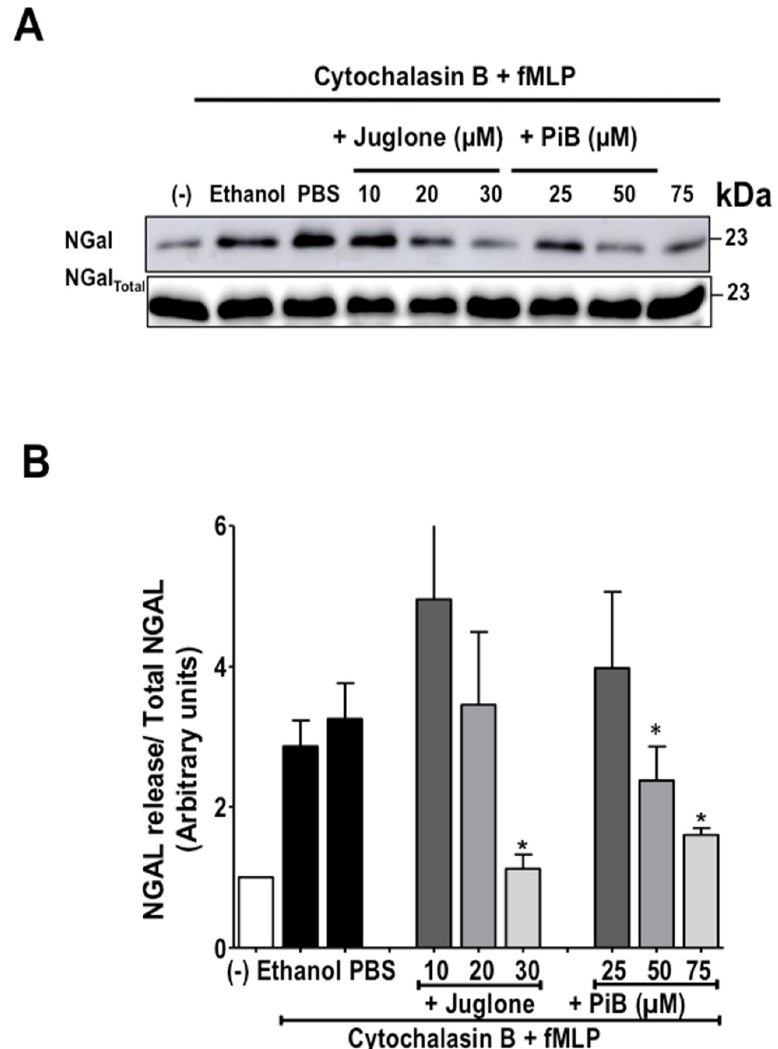
Figure 5. Effect of juglone and PiB on NGal release by human neutrophils. ( A ) Cells were pretreated or not with increasing concentration of Juglone dissolved in ethanol (0, 10, 20, 30 μ M) and PiB (0, 25, 50, 75 μ M), then with cytochalasin B (5 μ g/mL) before stimulation with fMLP (10 − 6 M). Control cells were treated with ethanol (0.001% or PBS) then with Cytochalasin B (5 μ g/mL) and stimulated by fMLP in the same conditions. After centrifugation, equal amounts of supernatant samples and neutrophils lysates were subjected to SDS-PAGE followed by immunoblot analysis with anti-NGal antibody. A representative Western blot of 4 experiments is shown. ( B ) Western blot results were quantified and expressed in arbitrary units (AU). Values are means ± S.E.M. n = 4 (* p < 0.05). 3.4. PiB Decreased Both Total ROS and Superoxide Anion Production We have previously shown that juglone inhibited NADPH oxidase priming [21–24]. Here we evaluated the effect of PiB on fMLP-induced ROS production and TNF-induced priming. We measured ROS production by the luminol-enhanced chemiluminescence as- say which detects multiple forms of ROS, mainly superoxide anion, hydrogen peroxide and hypochlorous acid. Results show that fMLP (at 10 − 7 M) induced release of low level